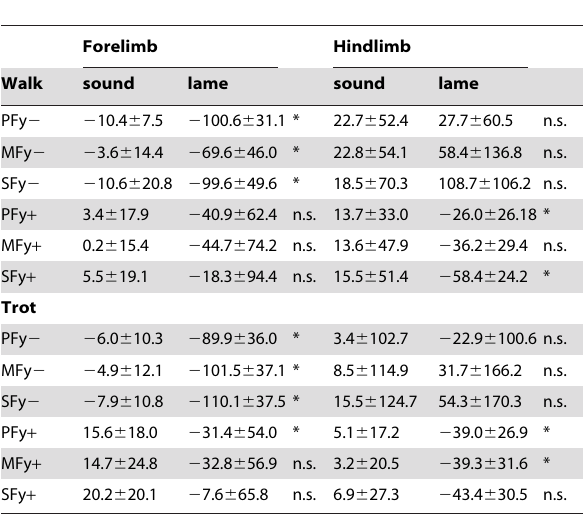
Table 3. Symmetry indices for mean (M) and peak (P) as well as the sum (S) of the braking (Fy-) and propulsive (Fy + ) forces for the sound condition and when lameness was induced.